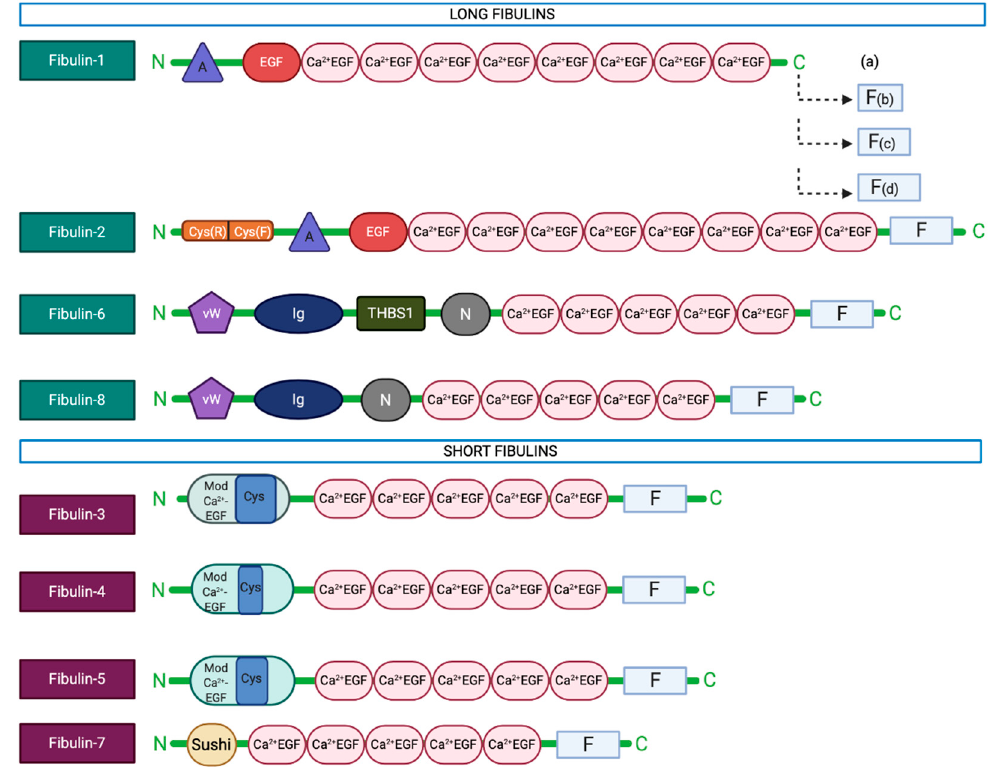
Figure 1. Fibulin family protein structures. A, anaphylatoxin-like domain; EGF, epidermal growth factor-like domain; Ca 2 + -EGF, calcium-binding EGF-like module; F, fibulin module; Cys(R) and Cys(F), cysteine-rich and cysteine-free sections of fibulin-2 C-terminal domain, respectively; vW, von Willebrand motif; Ig, immunoglobulin-like domain; THBS1, thrombospondin-1 motif; N, nidogen-like domain; Mod-Ca 2 + -EGF, modified Ca 2 + -EGF; Sushi, Sushi domain.